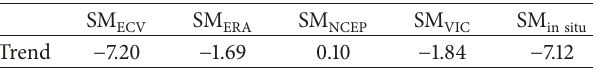
Table 2: The linear trends for annual time series during 1988–2010 as shown in Figure 6. They are expressed as the percentages (%) of soil moisture changes per decade (10a) with relevance to their long- term mean values.